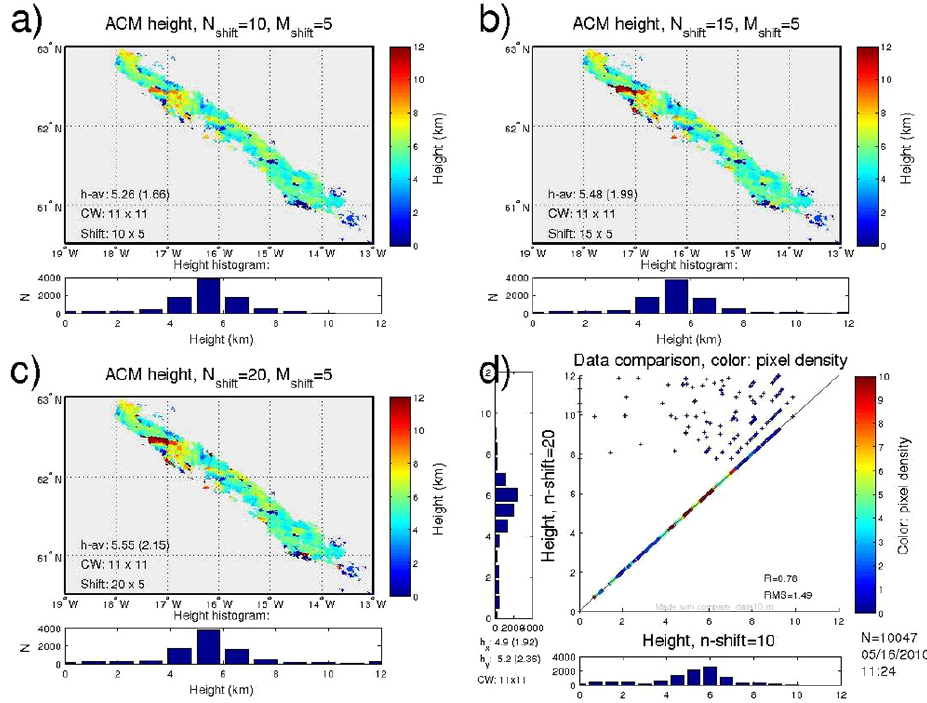
Figure 5. Effect of the maximum allowed along-track shift, N shift (or N ). Color scale is limited to 0 −− 9km although larger heights are possible, as seen in the height histograms (at the bottom of the figures). We see that most of the changes appear for the highest parts of the plume (as expected), but the scatterplot indicates other differences as well.